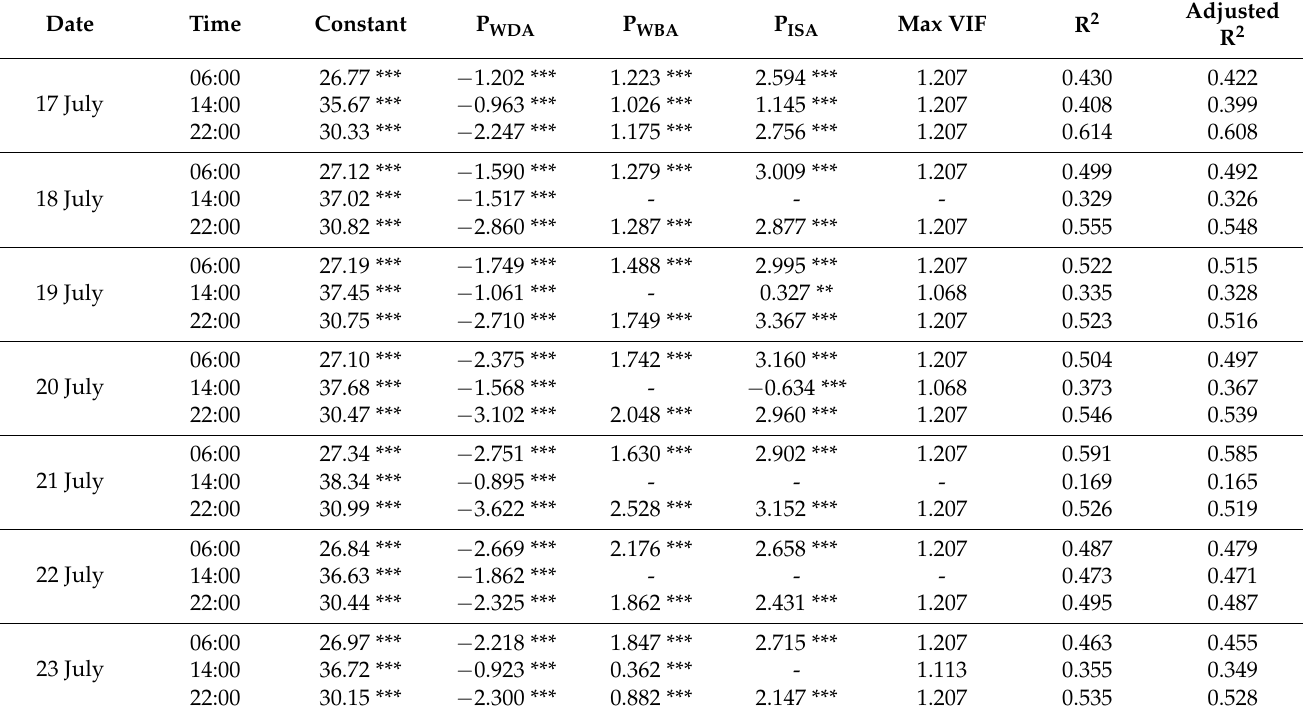
Table 2. Coefficients of the OLS regression with respect to air temperature.